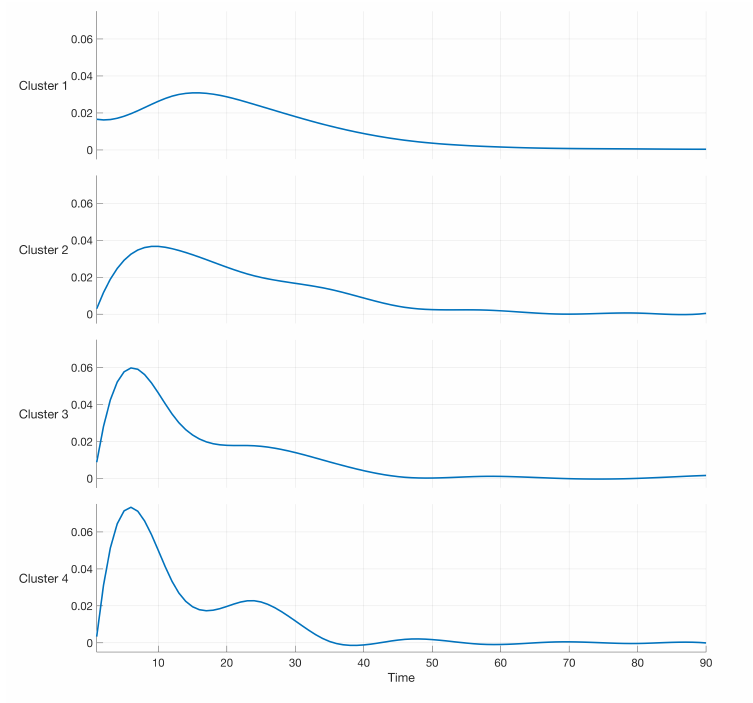
Figure 2. Cubic B-spline of order 4 modeling the data in the case